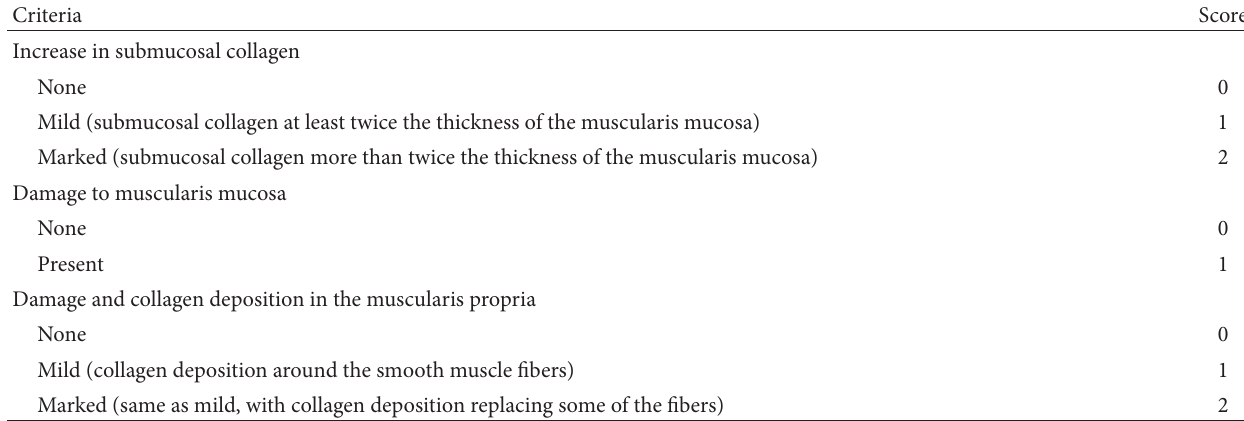
Table 1: Criteria for histopathologic